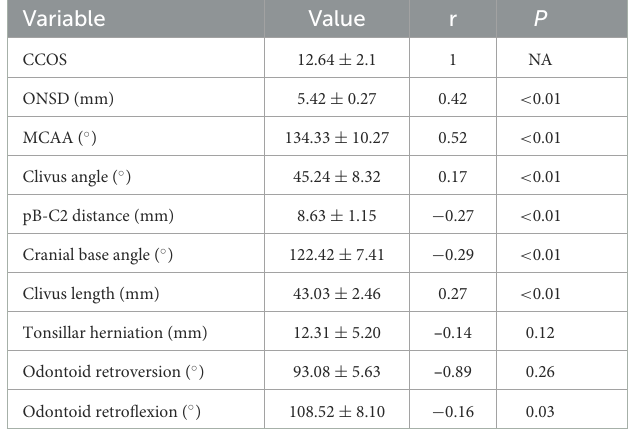
TABLE 3 The bivariate analysis of ONSD and other craniovertebral junction parameters with